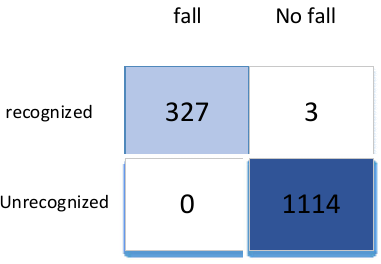
Figure 7. The confusion matrix on SisFall.